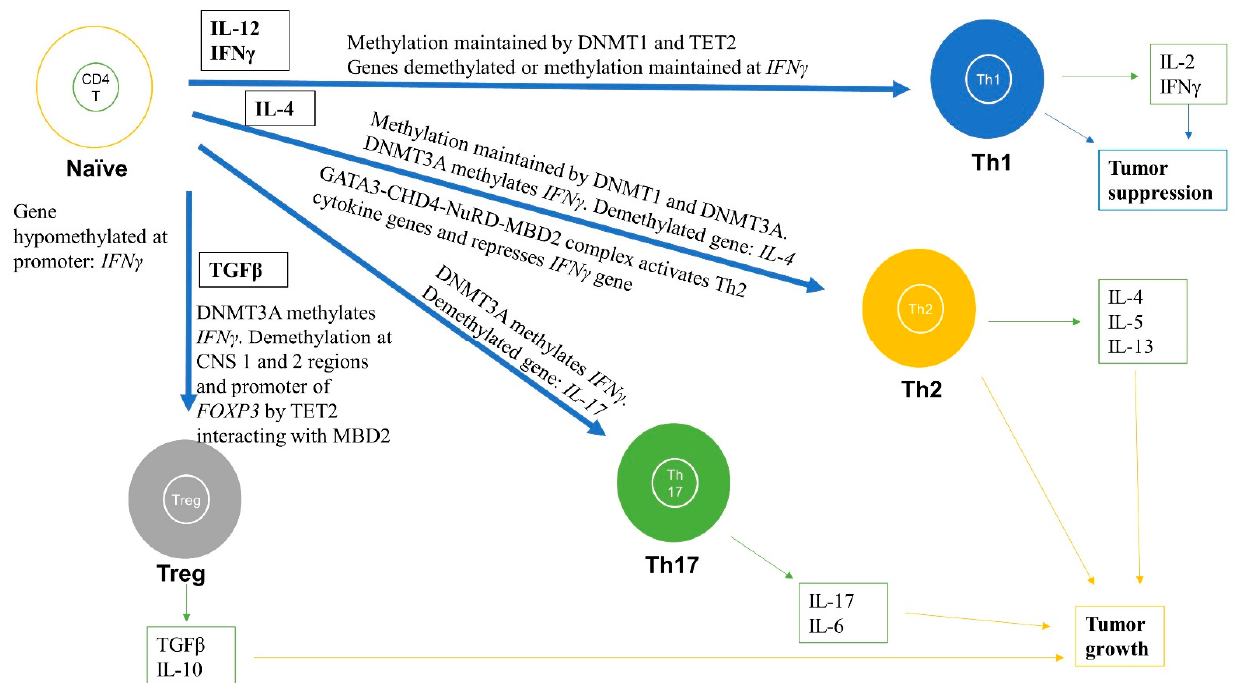
Figure 3. Role of DNA methylation in regulating differentiation and activation of naïve CD4 + T cells into effector cells including Th1, Th2, Th17, and Tregs subtypes. DNA methylation changes during differentiation can lead to formation of subtypes of CD4 + T cells. The black boxes are cytokines that help in the differentiation and activation process for each subtype. For instance, Th1 are formed when naïve CD4 + T cells are stimulated by IL-12 and IFN γ cytokines and the IFN γ gene promoter remains hypomethylated and IFN γ is highly expressed. For the Th2 subtype, the IL-4 gene is demethylated and is highly expressed, whereas IFN γ is methylated and repressed. For Th17 cells, the IL-17 gene is demethylated and highly expressed. For Tregs, FOXP3 is demethylated at various regions, including promoter and enhancer, thereby markedly increasing FOXP3 expression. These methylation levels are maintained by DNMT1, DNMT3A, and TET2. The green boxes indicate the cytokines released from differentiated cells. These immune cells and released cytokines can further lead to tumor progression or suppression.